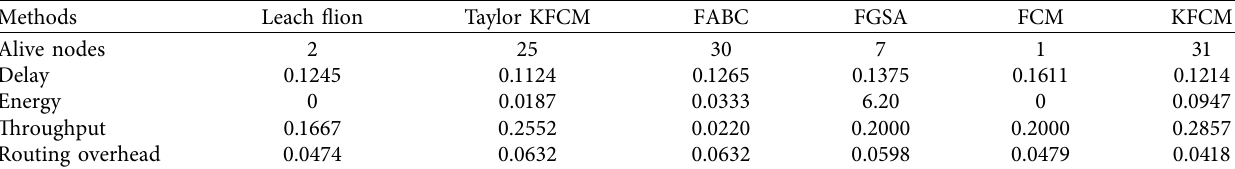
Table 1: Comparative results of different